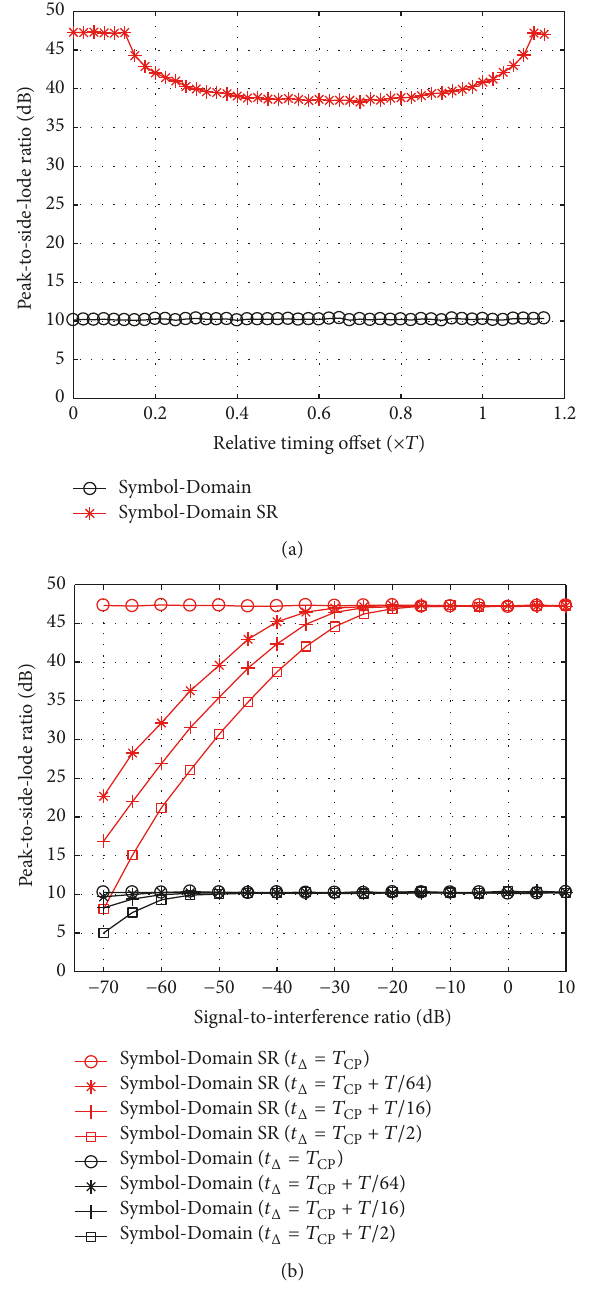
Figure 8: Peak-to-side-lobe ratio with multiuser interference when timing offset exists. (a) PSLR versus different relative timing offset when SIR = − 40dB. (b) PSLR versus different